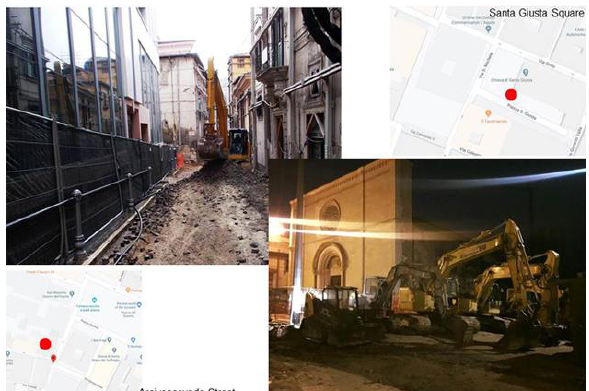
Figure 6. Among the streets where archaeological finds were discovered there are also via dell’Arcivescovado and Piazza Santa